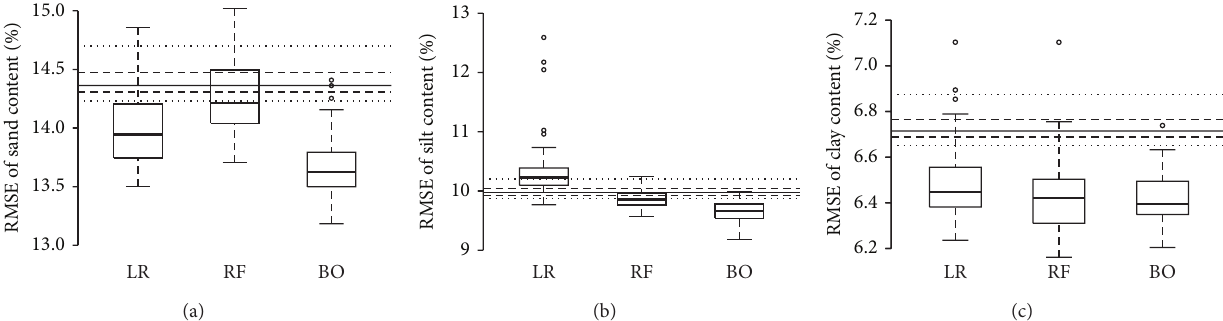
Figure 8: 5-fold cross-validated RMSE distributions of the selected modelling procedures. LM: linear regression; RF: random forest; BO: gradient boosting. The lines refer to the boxplot parameters of the RMSE distribution of the mean of the data as prediction model. Solid line: median; dashed line: upper/lower hinges; dotted line: upper/lower whiskers.